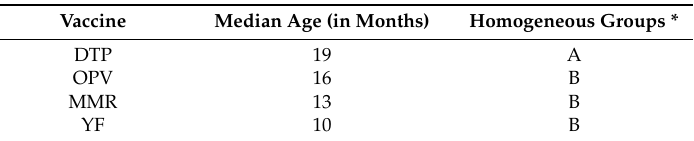
Table A2. Results of multiple comparisons of vaccines for median age (in months) of affected children with the 10 most reported adverse events using the Dunn hypothesis test, considering only single inoculation